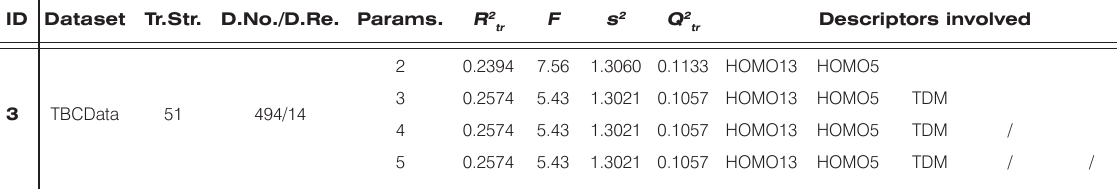
b) MLR models obtained by employing only QC molecular descriptors (Supporting Information Supplemental Table 3, case 3). ID Dataset Tr.Str. D.No./D.Re. Params.